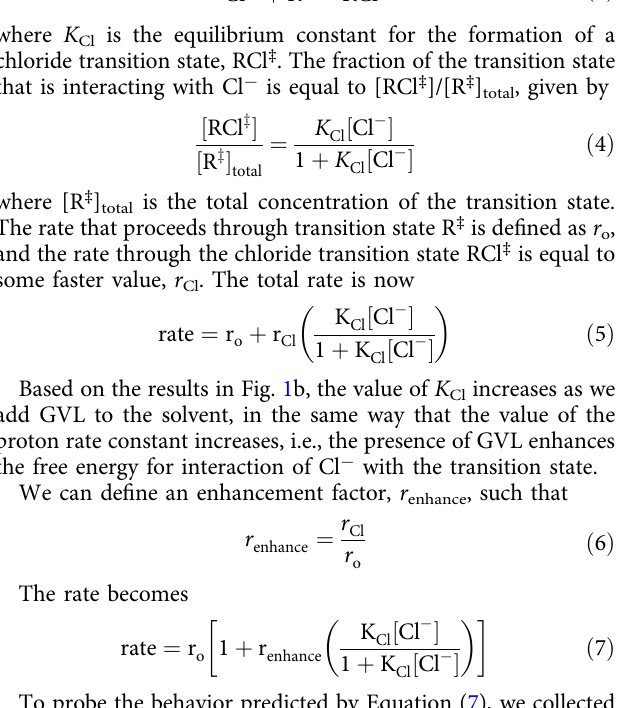
a ThevaluesforoxocarbeniumionformationarethereactionfreeenergiesforthesimultaneousprotonationoftheC2hydroxyloffructoseandtheeliminationofwaterthatforms. b Theprotonabstraction values refer to the activation free energies for water to deprotonate the oxocarbenium ion that forms. c The apparent activation barrier listed as the total activation free energy is the sum of the free energy of the reaction to form the oxocarbenium ion and the activation free energy to deprotonate it. d The free energy of oxocarbenium ion formation in 90% GVL/10% H 2 O (w/w) with HCl required a correction calculated from the 75% GVL/25% H 2 O (w/w) system to ensure the complete dissociation of the H + and Cl − in the initial reactant state as discussed in the Supplementary Discussion. e The tri fl ate anion migrated away from fructose and local water molecules during the free energy sampling and partitioned between the water and GVL domains away from the active site. The numbers reported in this column were therefore taken from the 90% GVL/10% H 2 O (w/w) system without an anion. The double dagger ( ‡ ) symbol is a descriptor that refers to the transition